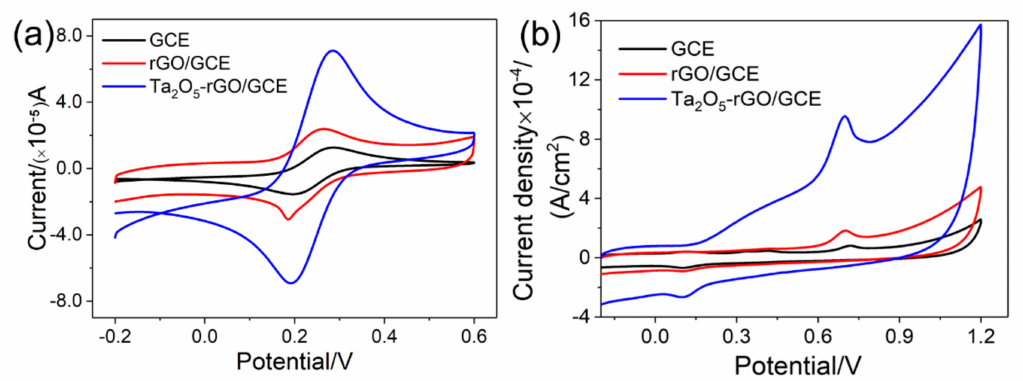
Figure 3. ( a ) Cyclic voltammetry (CV) curves of 5.0 × 10 − 4 mol / L of K 3 Fe(CN) 6 at di ff erent electrodes (bare GCE, rGO-GCE and Ta 2 O 5 -rGO-GCE); ( b ) Electrochemical behaviours of tryptophan (1.0 × 10 − 5 mol / L) on bare GCE, rGO and Ta 2 O 5 -rGO electrodes (scan rate: 0.1 V / s,